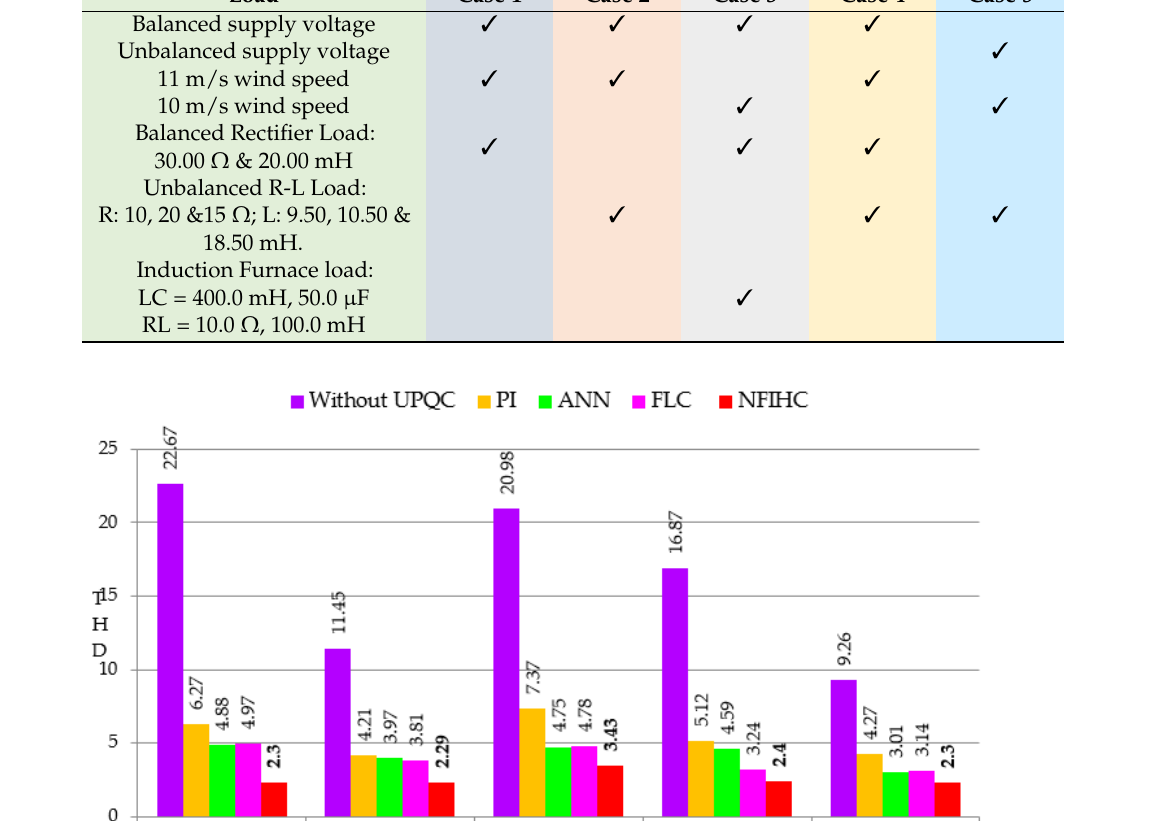
Algorithms 2022 , 15 , x FOR PEER REVIEW Figure 13. THD comparison of the proposed method with the controllers considered in the study.